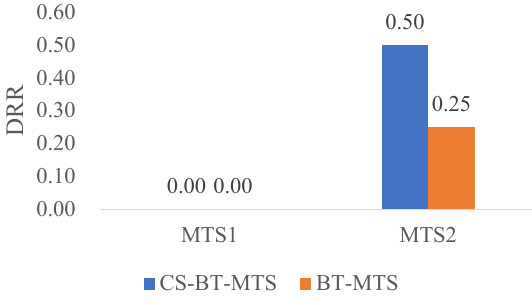
Figure 4. Comparison of DRR of the balance data set.